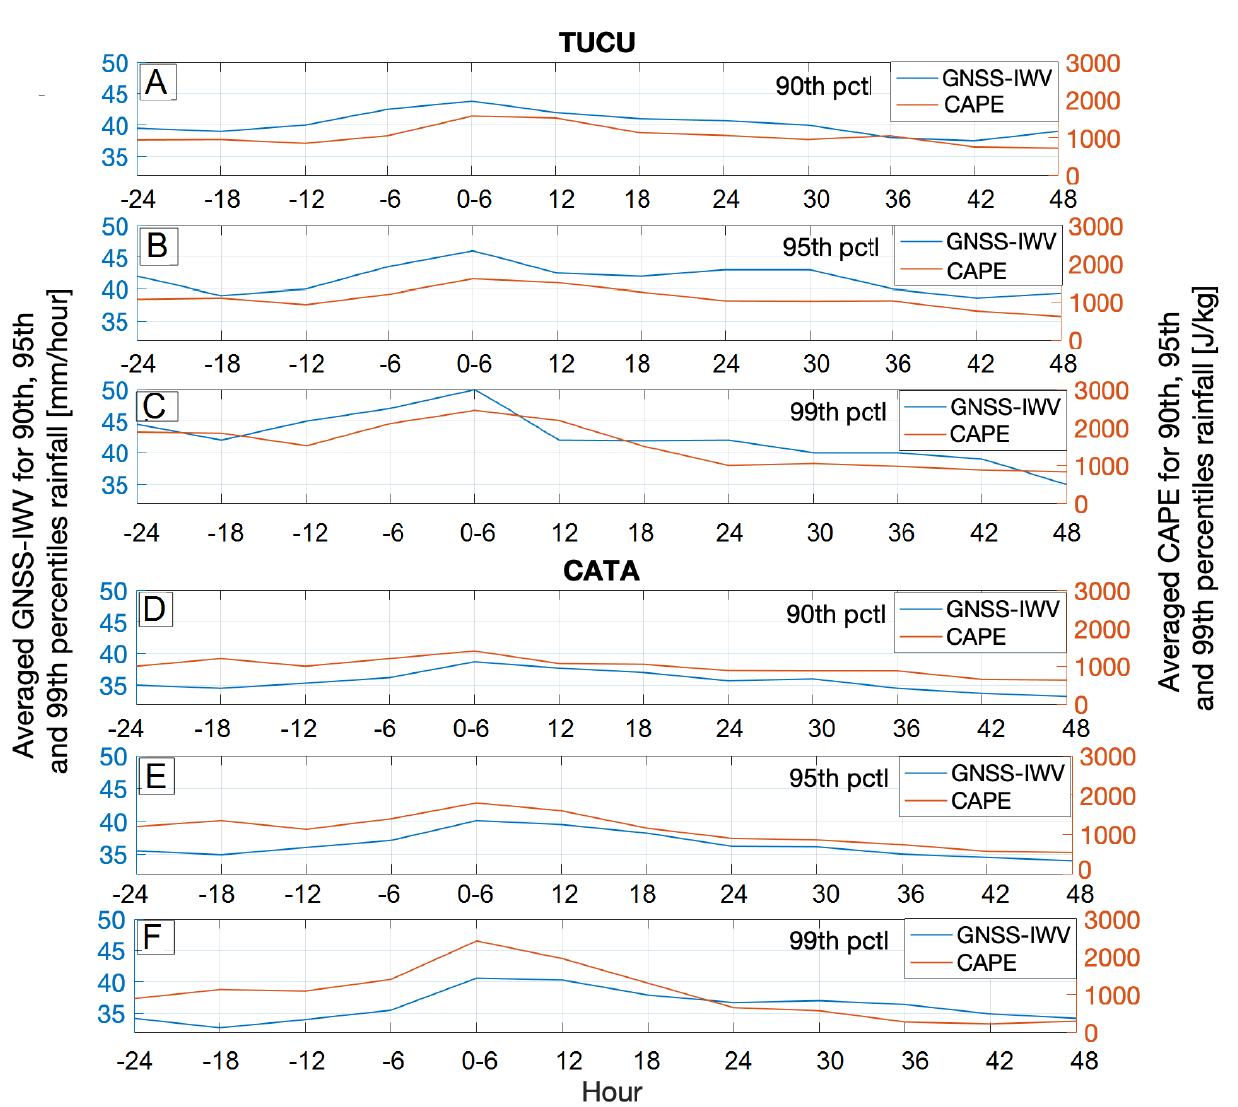
Figure 11. Averaged GNSS-integrated water vapour (blue line) and CAPE (red line) for the TUCU and CATA stations for the 90th percentile rainfall ( A , D ), for the 95th percentile rainfall ( B , E ), and for the 99th percentile rainfall ( C , F ). We selected all times with rainfall above the 90th, 95th, and 99th percentiles, respectively and their corresponding GNSS-integrated water vapour and CAPE amounts. We then show the correlation for 72 h (event day plus day before and day after). Note that the GNSS-integrated water vapour and CAPE generally increase during the day before the event and that peak values—both for GNSS-integrated water vapour and CAPE—are observed at the day of the 90th, 95th, and 99th event